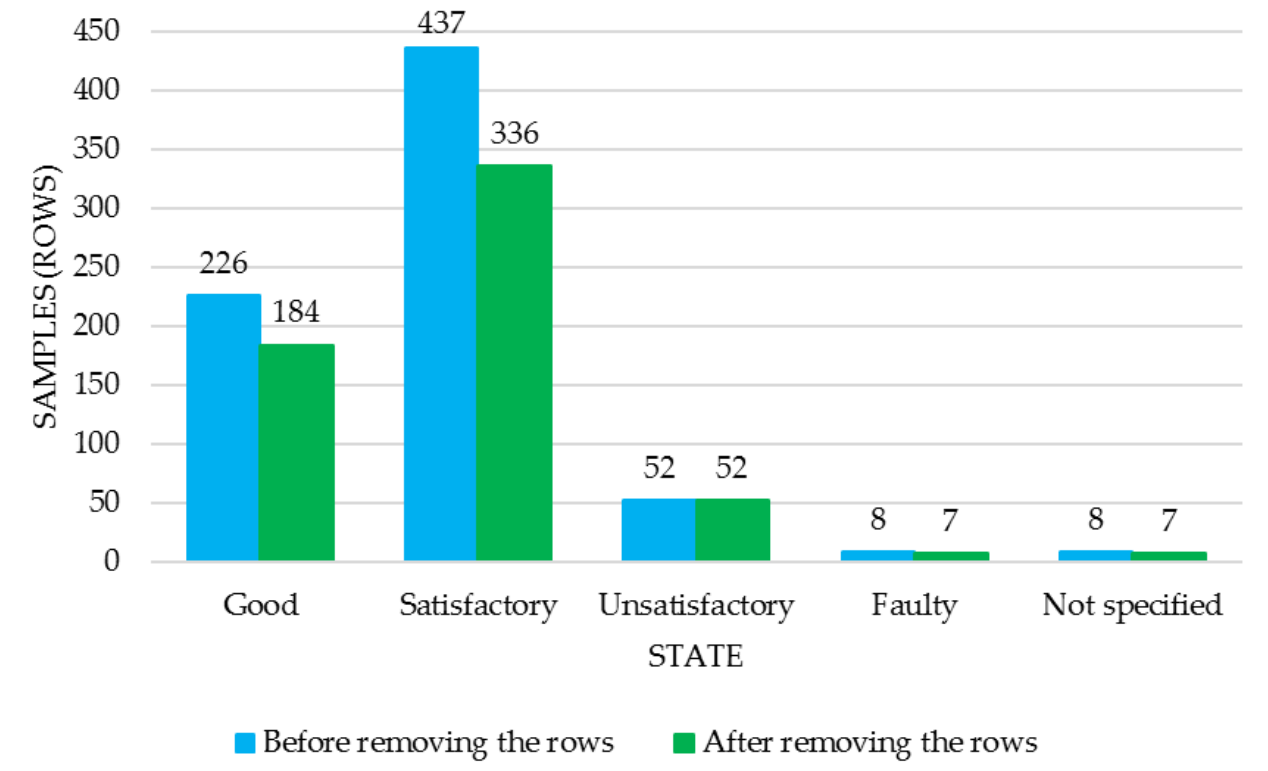
Figure 4. Data distribution by transformer states.